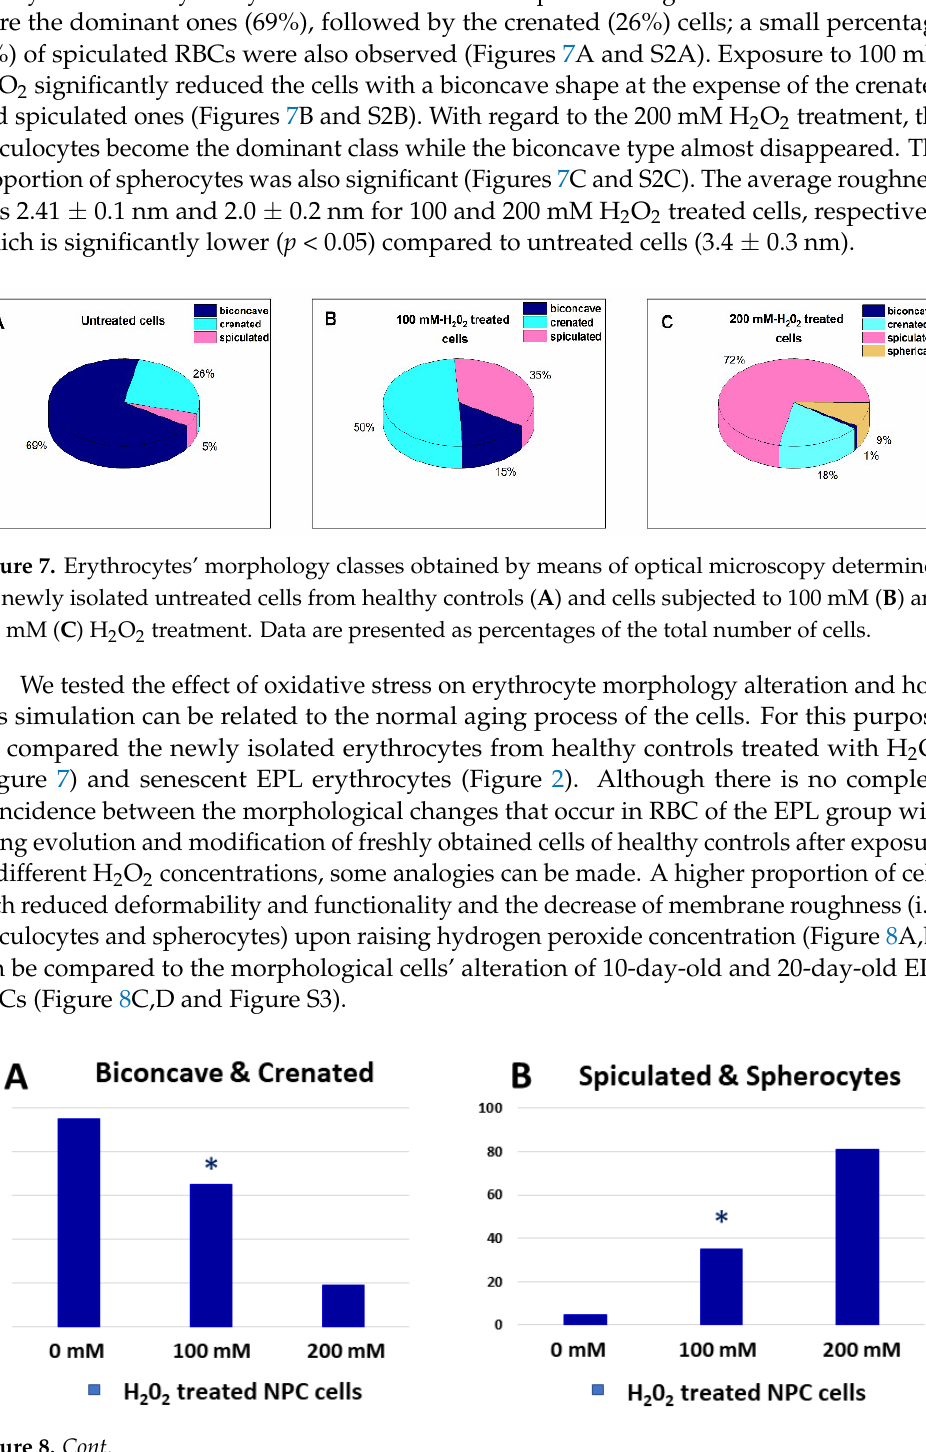
Figure 8. Comparison between the percentages of the morphological types of newly isolated cells from healthy controls treated with H 2 O 2 ( A , B ) and EPL erythrocytes 10-day-old and 20-day-old ( C , D ). Non-parametric Wilcoxon test was applied to determine statistical differences in the value of the fraction of different morphological types of H 2 O 2 treated cells, which are given as p values, indicated as * p < 0.05 relative to the respective morphological fractions of 10-day-aged EPL eryth- rocytes.